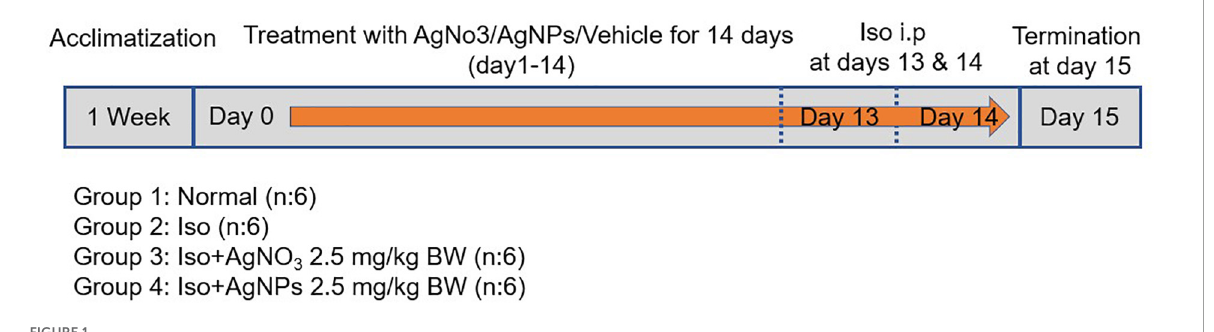
FIGURE1 The timeline of in vivo study.